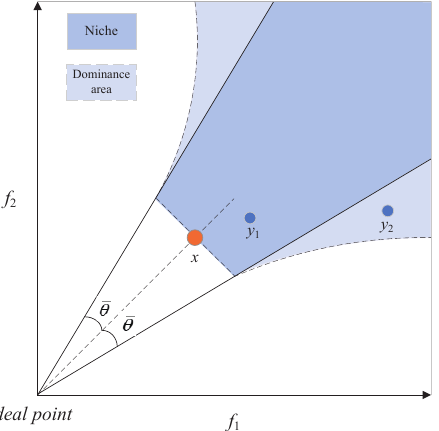
Figure 1. Dominance area of solution x obtained by SDR in bi-objective